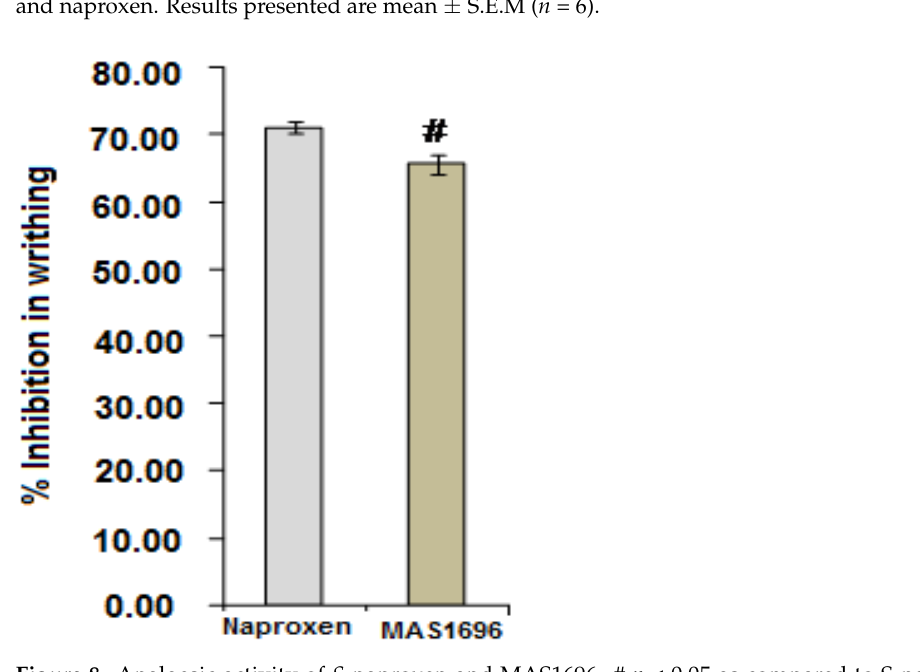
Figure 9. Comparative effect of S -naproxen (120 mg/kg), the molar equivalent of MAS-1696, and S - naproxen and 4-allyl guaiacol physical mixture (Nap + 4-AG) on gastric damage in the stomach. * p < 0.05 vs. vehicle-treated group; # p < 0.05 vs. naproxen-treat group. Results presented are mean ± S.E.M. of six animals in each group.